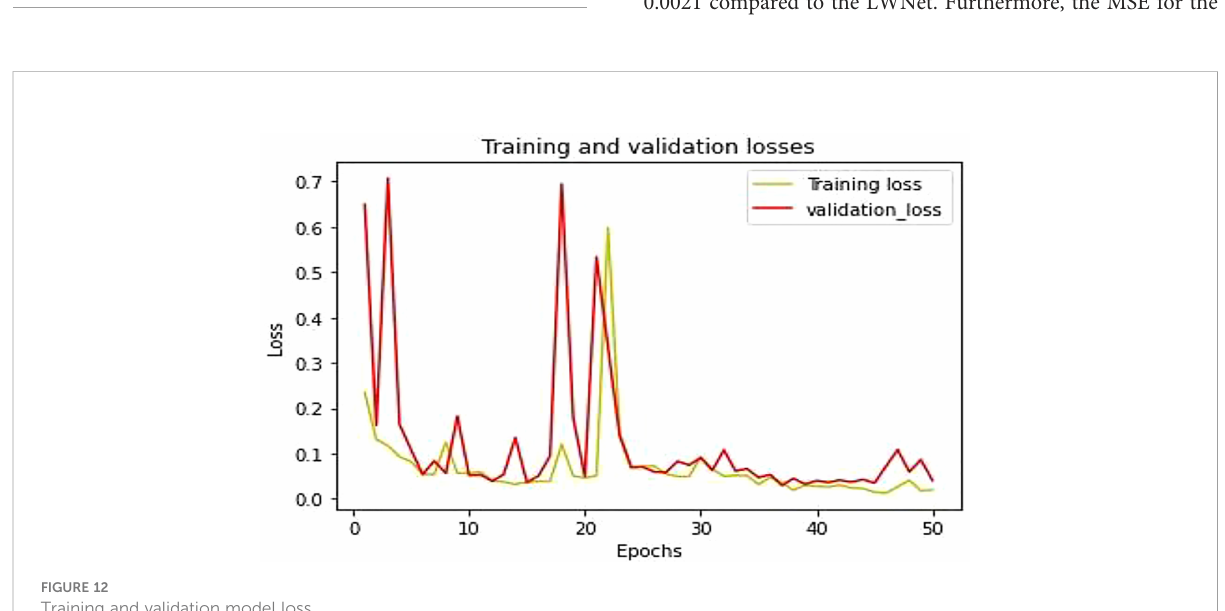
FIGURE 12 Training and validation model loss.